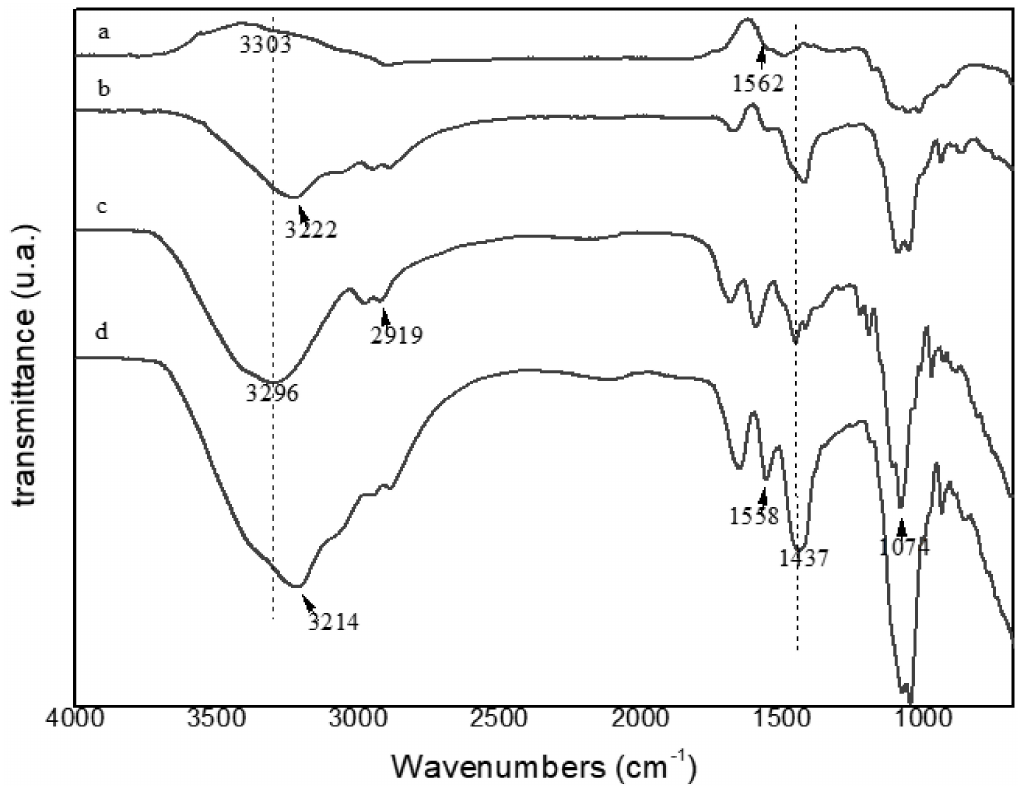
Figure 4. Fourier transform infrared (FTIR) spectra of (a) chitosan polymer, (b) agar-agar polymer, (c) ESF, and (d)